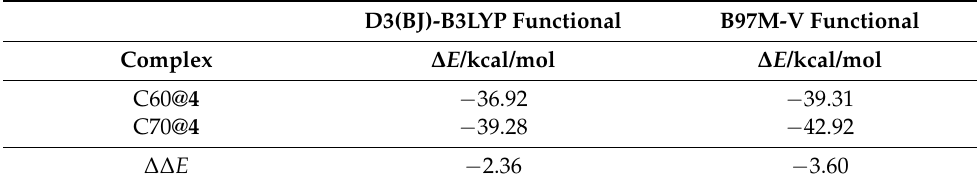
Table 4. Electronic binding energies 1 for complexation of 4 with